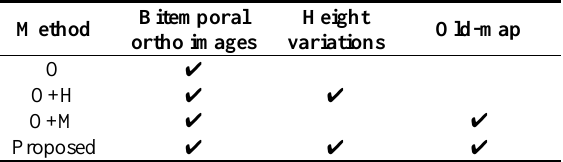
Table 2. Input data types for comparison of methods